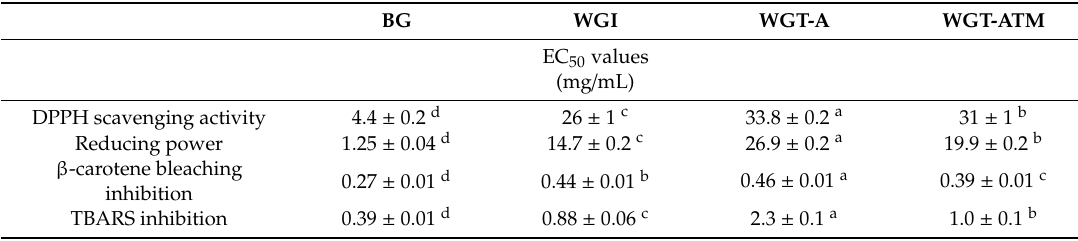
Table 3. Antioxidant properties of A. sativum samples (mean ±